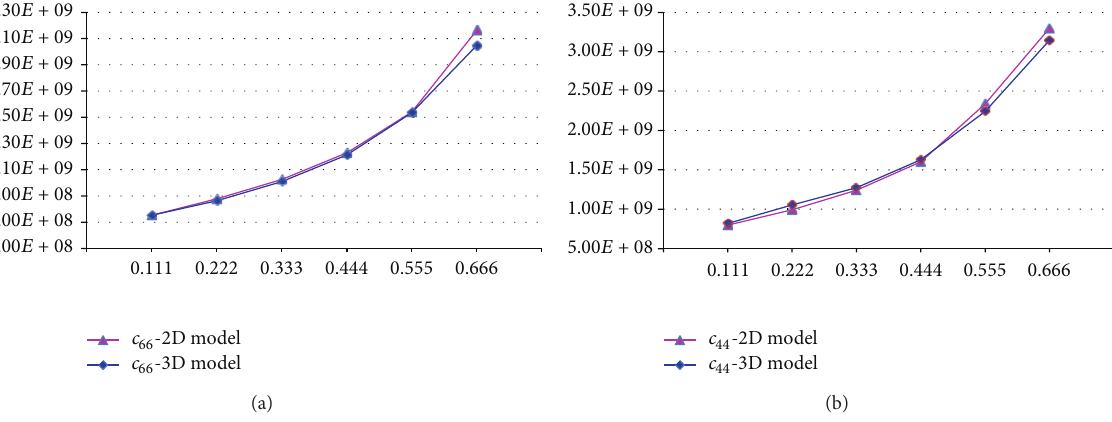
Figure 17: Comparison between the results derived from 2D and 3D models for c 44 and c 66